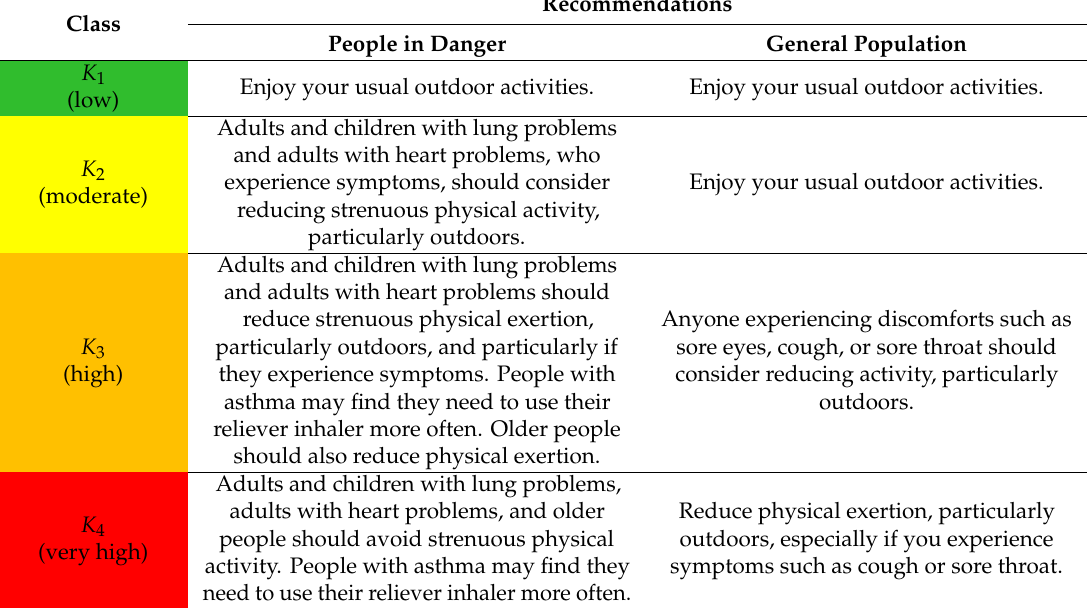
Table 5. Recommendations